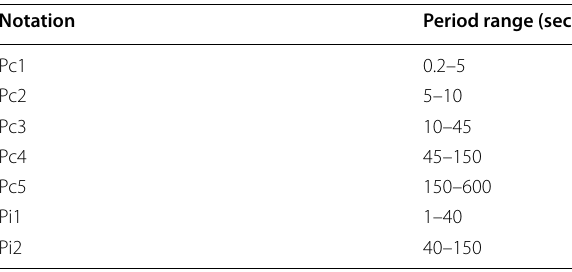
Table 2 Specifications of the CT6845 current